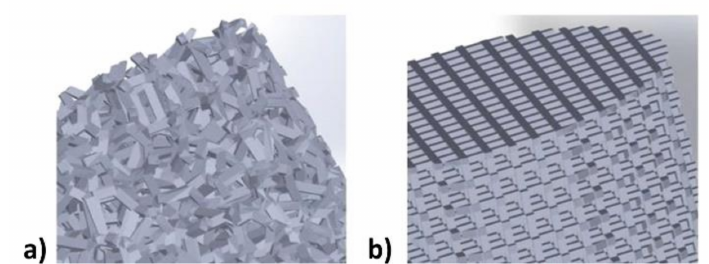
Figure 3. Details of the ( a ) trabecular and ( b ) cubic sample